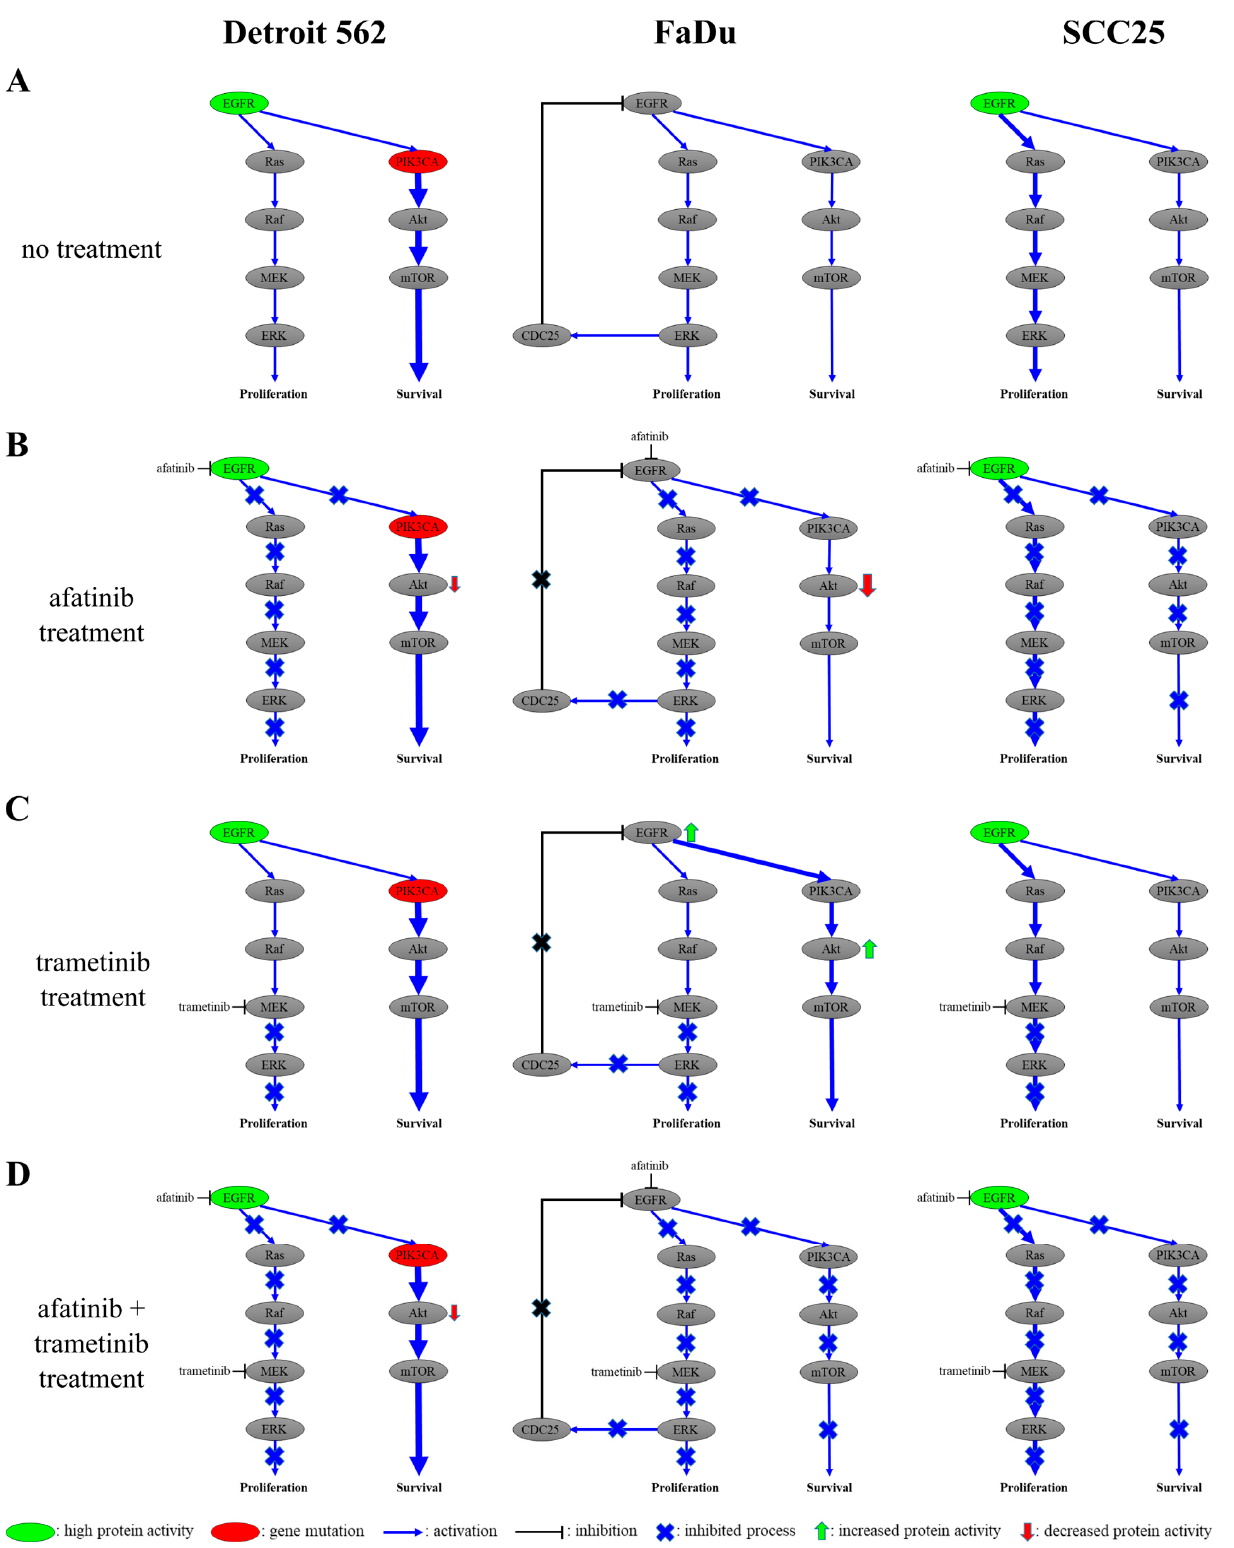
Figure 8. Signaling models for in vitro head-and-neck-cancer-cell lines. These models are based on our protein-expression and -phosphorylation measurements and viability assays. ( A ) The EGFR- initiated signaling in untreated cells. The PI3K/Akt pathway is significant in Detroit 562 cells due to the PIK3CA mutation, the MEK/ERK and PI3K/Akt pathways are equally strong in FaDu cells and the MEK/ERK pathway is dominant in SCC25 cells. An ERK/CDC25/EGFR feedback loop is present in FaDu cells. ( B ) Signaling under afatinib treatment. Upon treatment with afatinib, the pathways